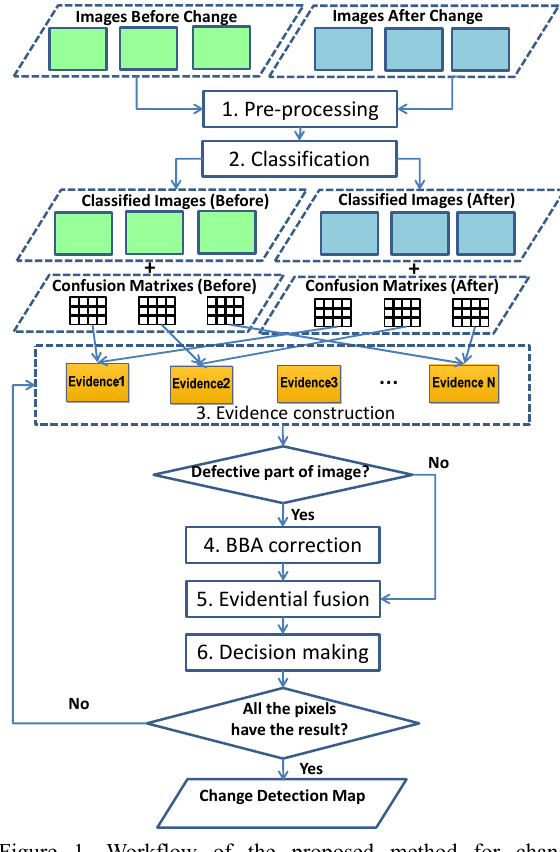
Figure 1. Workflow of the proposed method for change